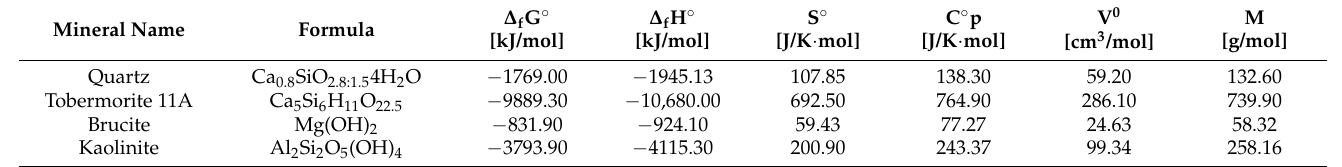
Figure 16. XRD analysis of sample BP10-W5. Table 4. Standard molar thermodynamic properties of minerals in silicate bricks